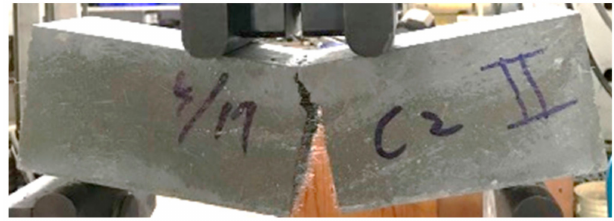
Figure 4. Failure of the experimental group specimen in flexure test.